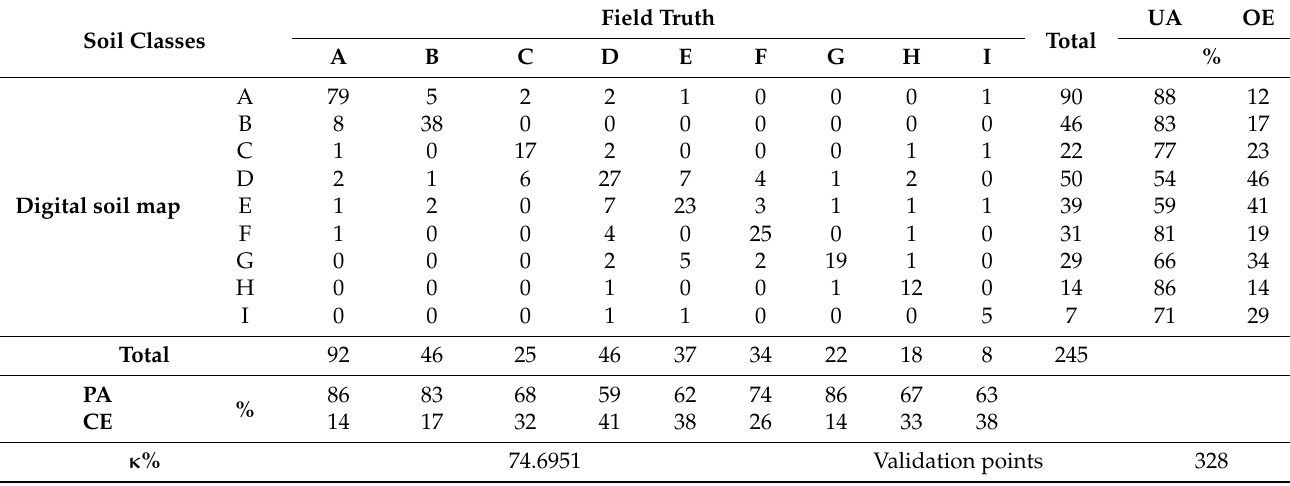
Table 6. Confusion matrix for digital soil